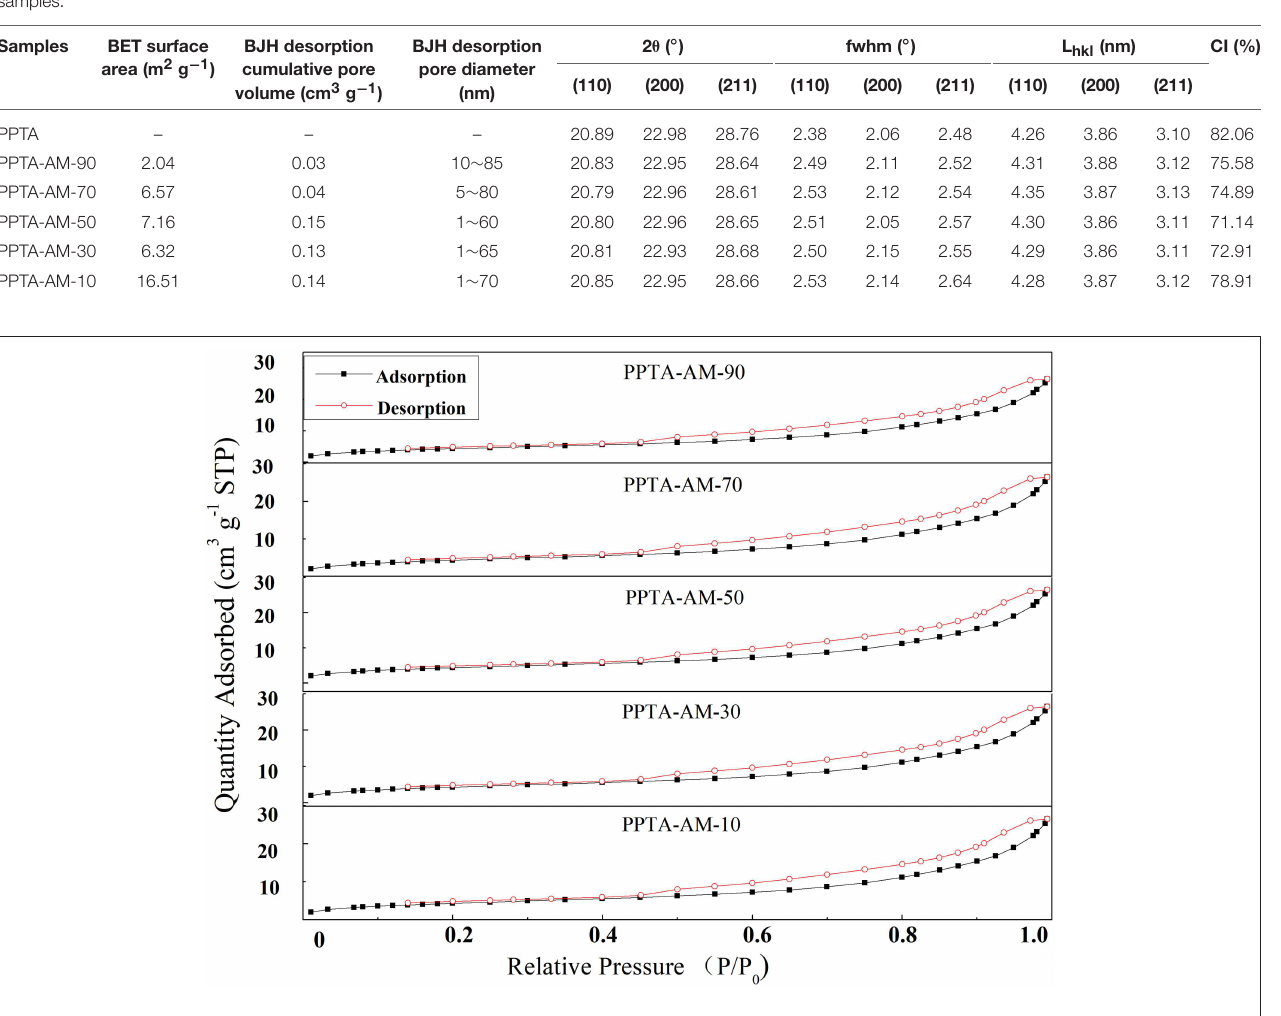
FIGURE 5 | Nitrogen adsorption–desorption isotherms of PPTA-AM